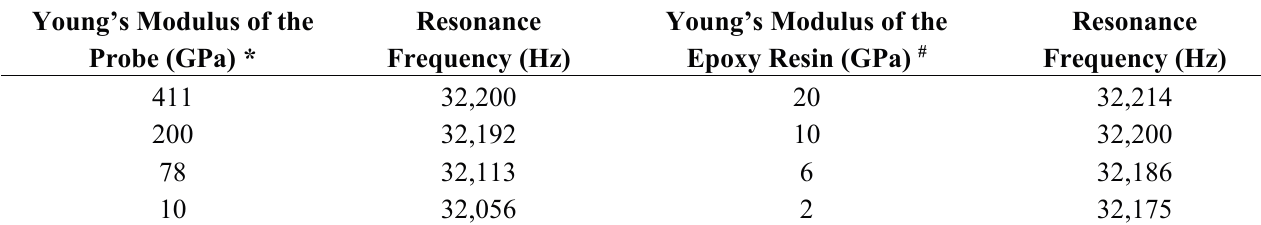
Table 9. Resonance frequency with Young’s modulus.